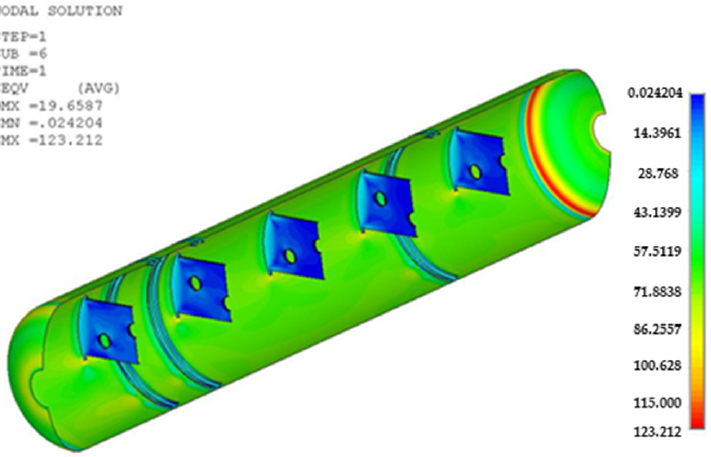
Figure 10. Case 3 principal stress distribution. ( a ) Entire computational domain showing region of maximum stress (position 2). ( b ) Position 2 element analysis result in detail.